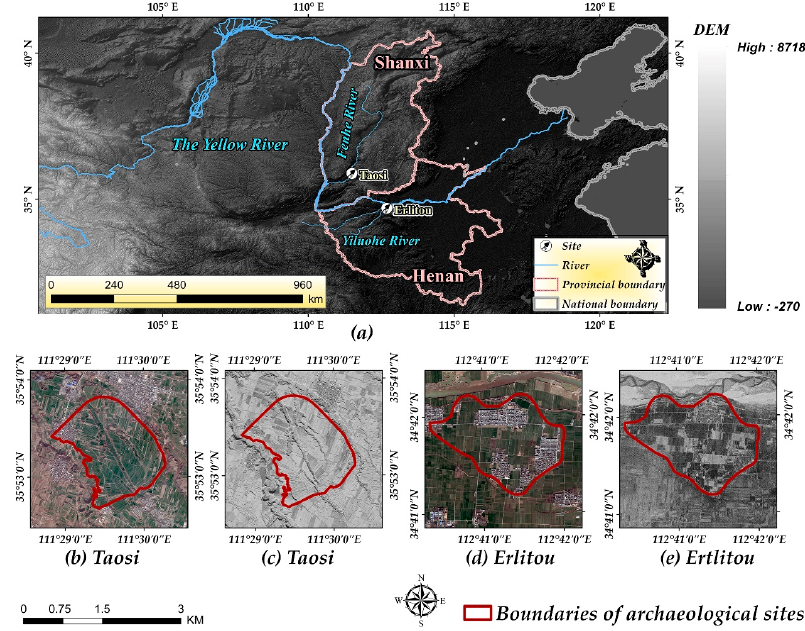
Figure 1. The location of study sites in China. ( a ) Both of the sites are located in the Yellow River valley. The Taosi site is located to the east of the Fenhe River, while the Erlitou site is located between the Yihe River and Luohe River. The true color images of high spatial resolution: ( b ) Taosi, 2 December 2010, Geoeye; ( d ) Erlitou, 30 December 2010, WorldView-2, and Corona panchromatic imagery: ( c ) Taosi, 5 November 1968; ( e ) Erlitou, 18 April 1962.